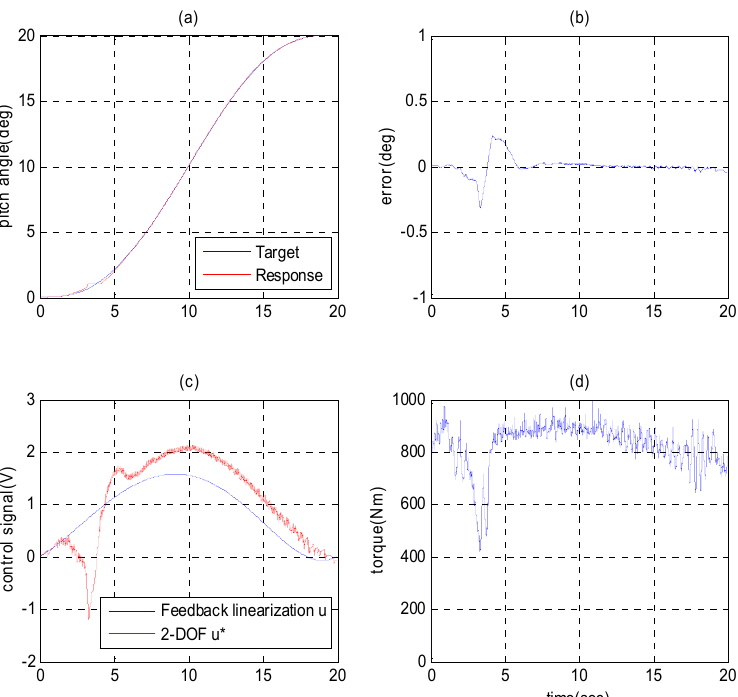
Figure 11. Experimental results of path ‐ positioning control of pitch angle with stroke 15° in 20 sec and load torque: ( a ) Pitch angle response; ( b ) Pitch angle error; ( c ) Comparison of control signals; ( d ) Disturbance load. Energies 2016 , 9 , 791